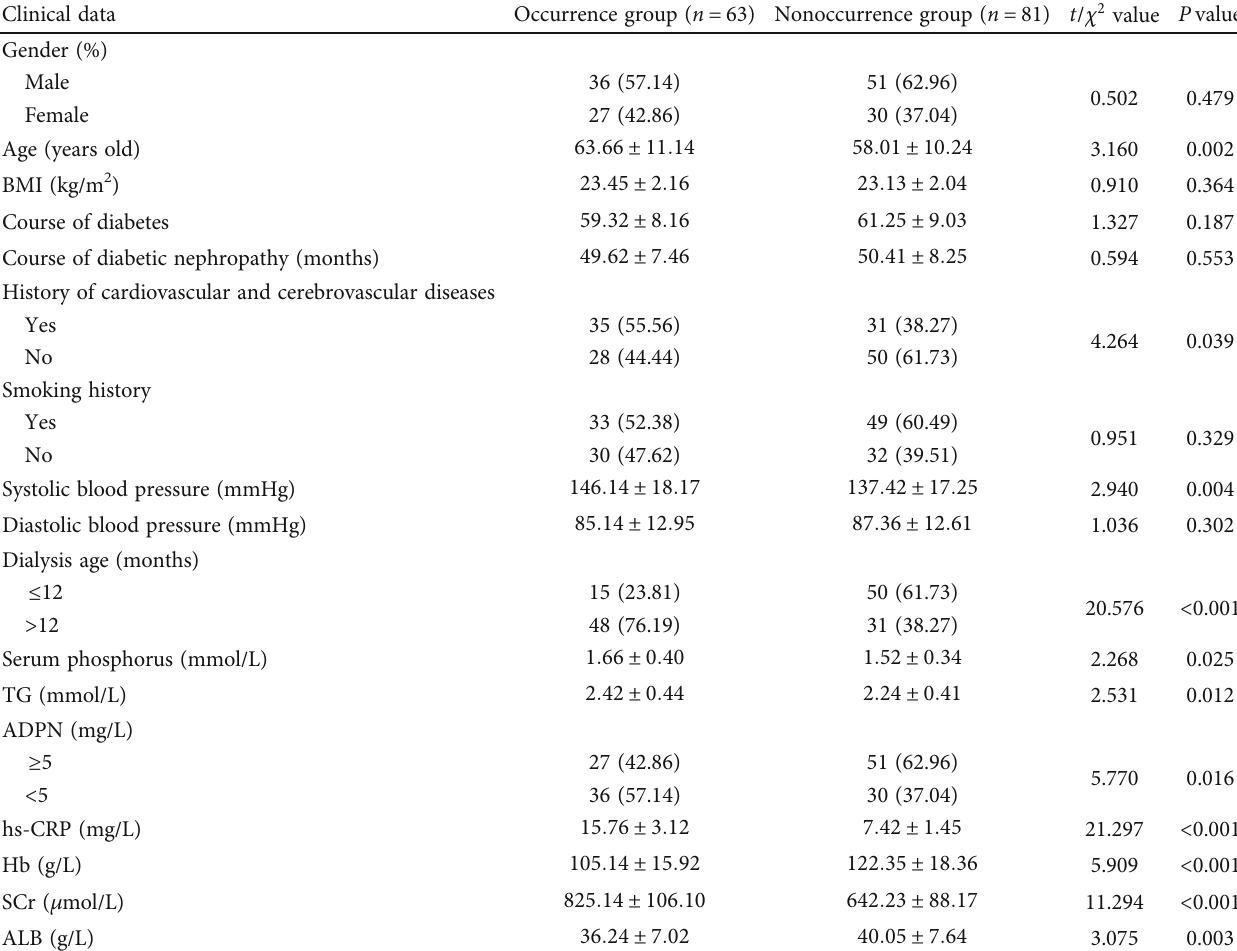
Table 1: Comparison of clinical data between the occurrence group and the nonoccurrence group. Clinical data